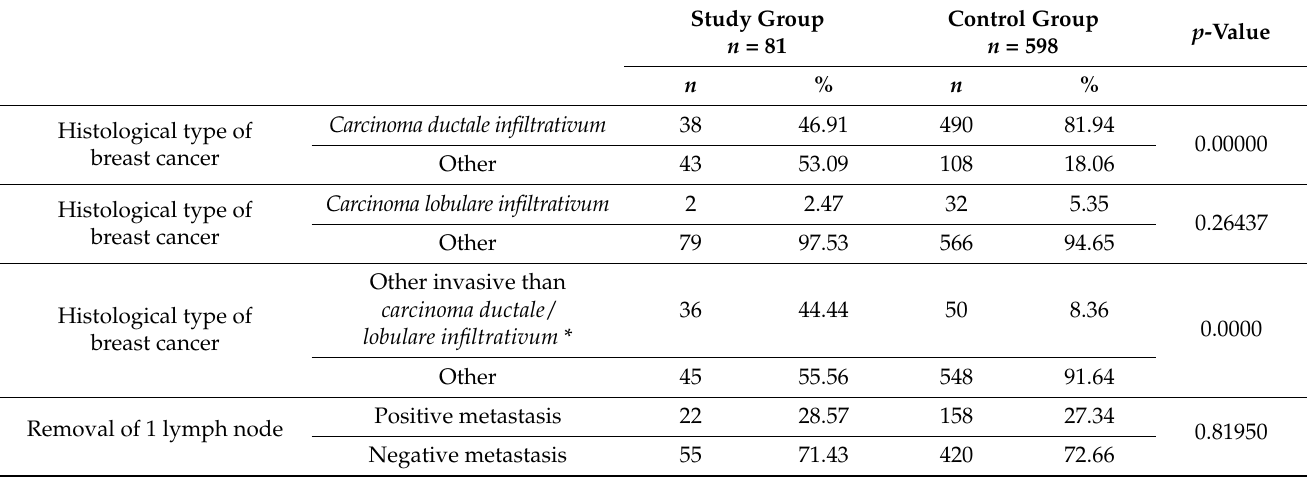
Table 2. Characteristics of the breast cancer patients with the results of the χ 2